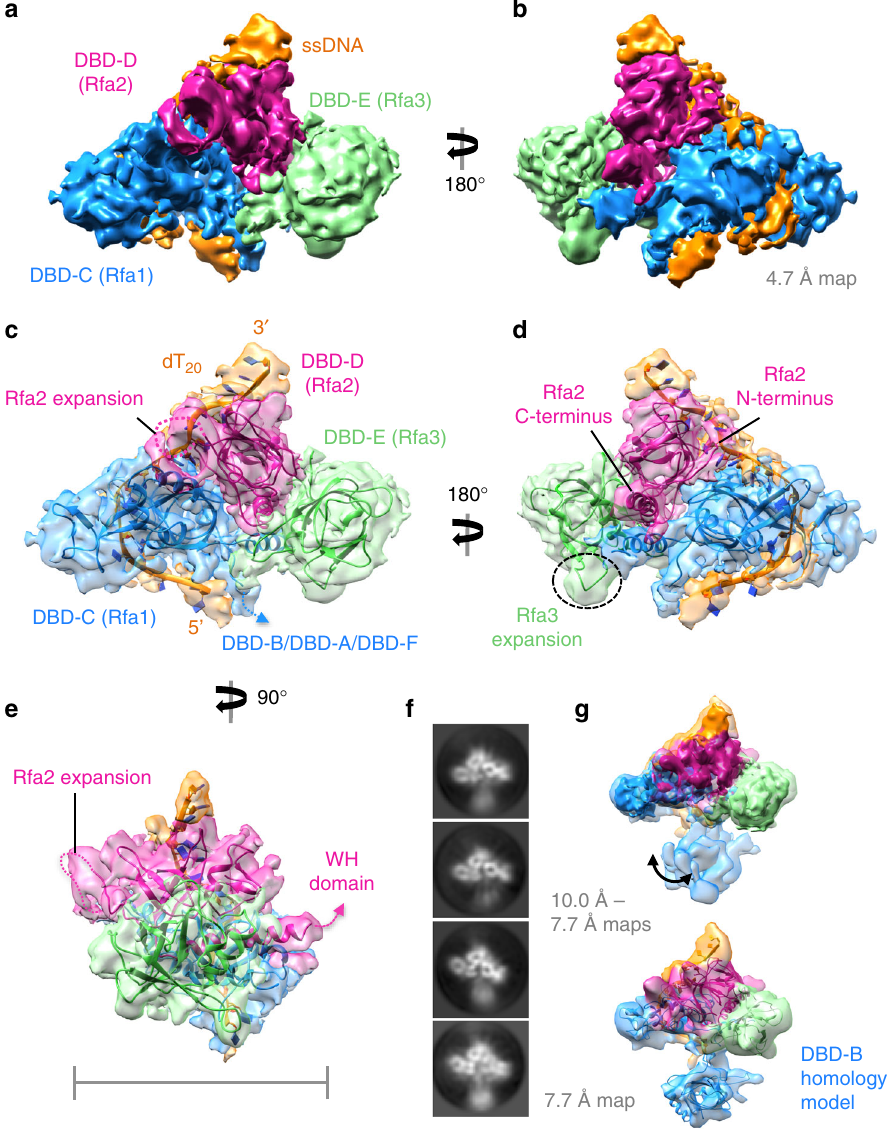
Fig. 2 Cryo-EM structure of ScRPA trimerisation core. a , b Cryo-EM reconstruction of ScRPA trimerisation core determined to 4.7 Å resolution by gold standard-FSC, post-processed and sharpened in Relion and colored by subunit; Rfa1 in blue, Rfa2 in pink, Rfa3 in pale green, and poly-dT in orange. c – e Orthogonal views of a fi tted and re fi ned homology model of ScRPA Tri-C. The subunits are colored as in a and a number of yeast-speci fi c features in Rfa2 and Rfa3 that are expansions of the amino-acid polypeptide chain protrude and from loops that are visible in the cryo-EM map. The polypeptide chain linkers (missing in the structure) to the C-terminal winged-helix domain and N-terminal phosphorylation domain of Rfa2 are labeled, as well as the DbdB-DbdA and N-terminal domain of Rfa1. Scale bar represents ~70 Å. f Representative 2D-class averages showing an additional domain underneath the Tri-C that is positionally fl exible. g Three individually re fi ned maps from sub-classi fi cation of the data at sub-nanometer resolution, by gold standard- FSC (see Supplementary Fig 4), aligned on the Tri-C and fi tted with 4.7 Å Tri-C map showing an additional small domain and its different locations in each map. The apparent domain motion is arrowed. Below, the highest resolution map (7.7 Å) with fi tted atomic model from c showing that the additional density region is suf fi cient to fi t an OB-fold. A homology model for DbdB is fi tted and shown. Figures were generated in UCSF Chimera